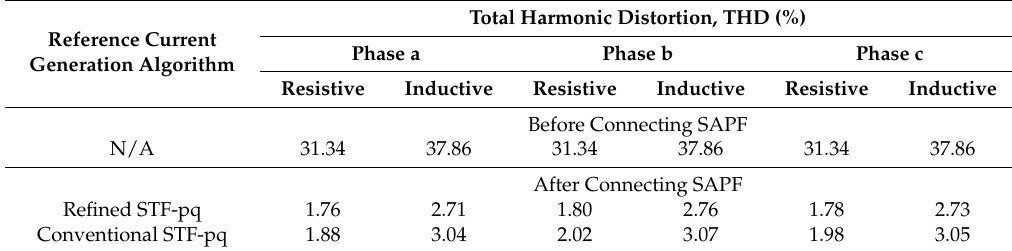
Table 3. THD values of source current i S under case 2 non-sinusoidal source voltage condition (Simulation